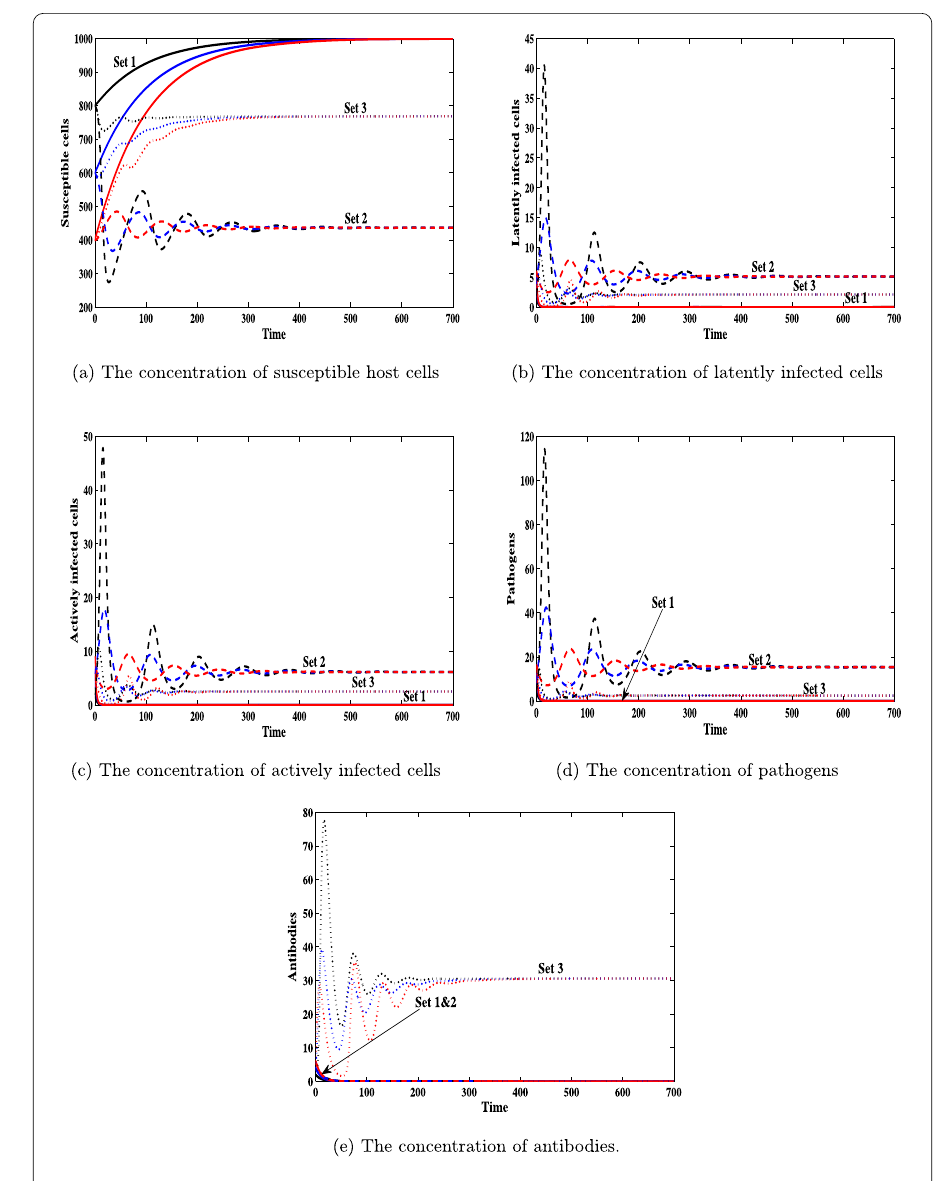
Figure 1 The simulation of trajectories of system (2) for Case